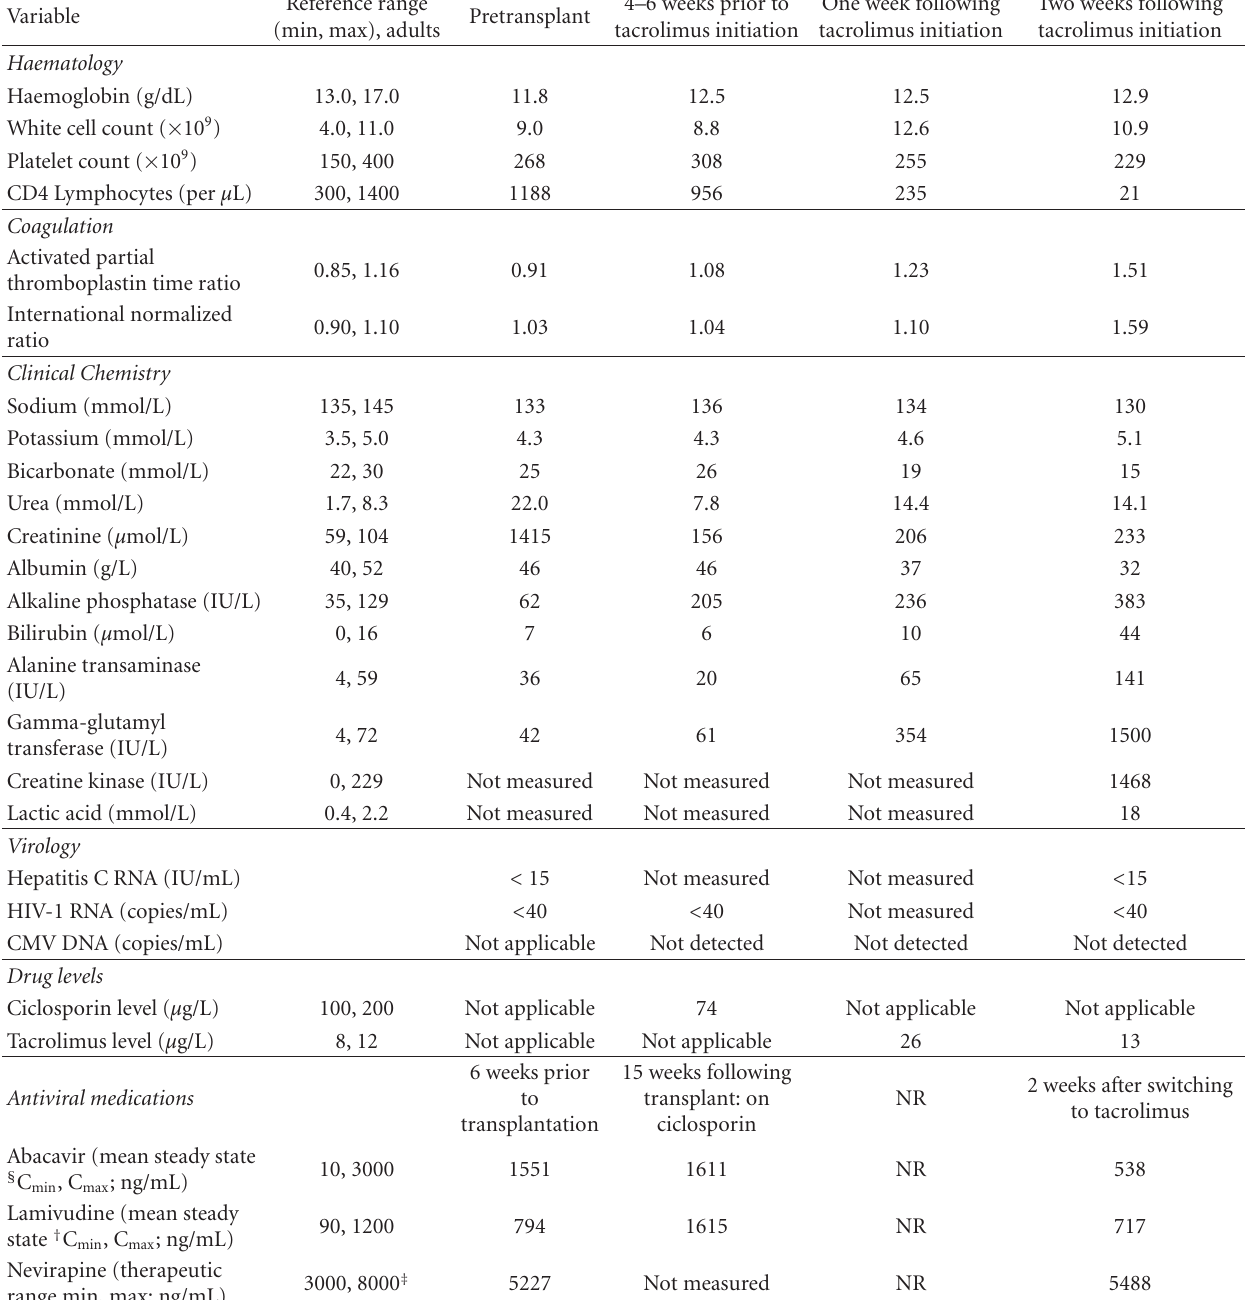
Table 1: Haematology, biochemistry, thrombosis, and virology test results at various time points prior to and following renal transplantation.